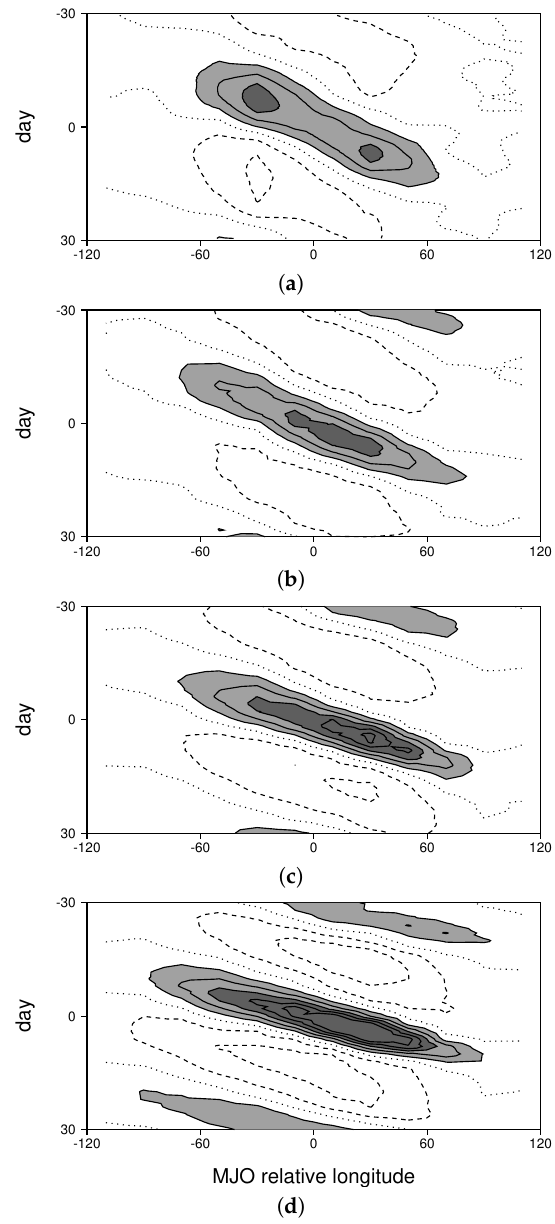
Figure 1. Composite time/longitude series of rainfall for: ( a ) the observed MJO; ( b ) the control run; ( c ) the 3 K warming experiment; and ( d ) the 7 K warming experiment. The contour interval is 1 mm/day with values greater than 1 (3) mm/day shaded light (dark)